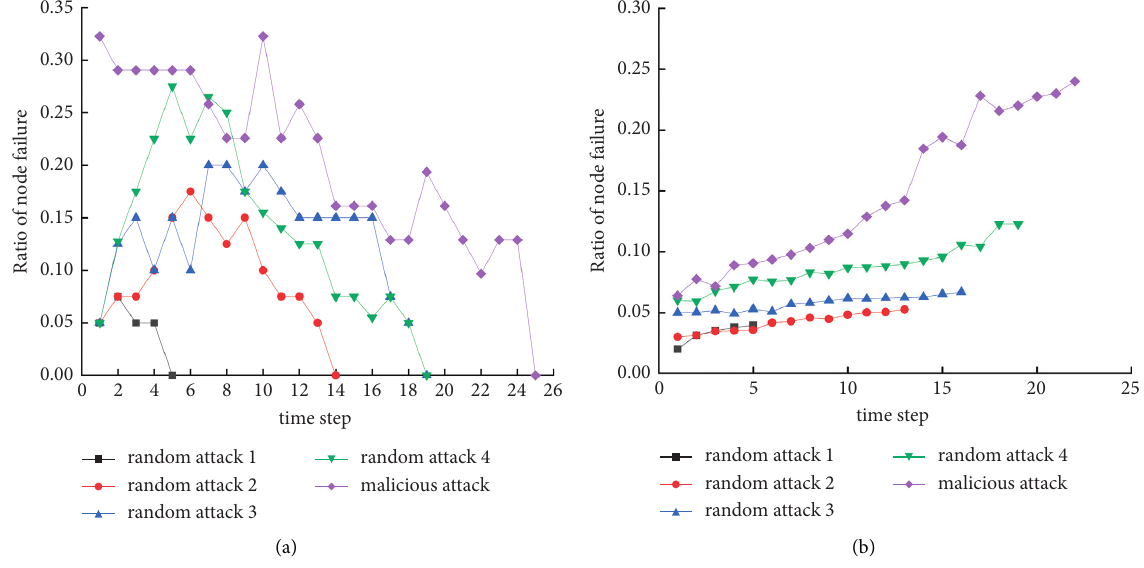
Figure 9: The vulnerability of the BRTN under different attacks: (a) ratio of node failure and (b) loss flow ratio.